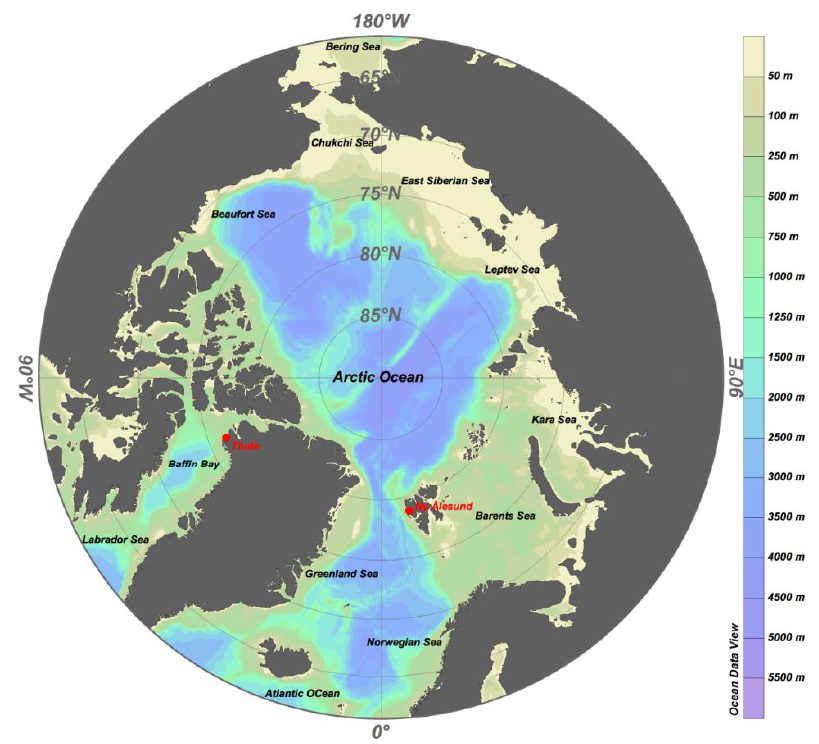
Figure 1. Map of the Arctic with the sampling sites.